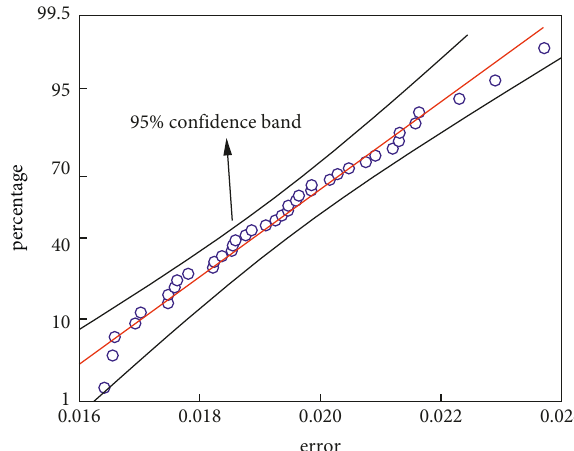
Figure 7: The reliability distribution of predicted value of Hanfu shape feature.